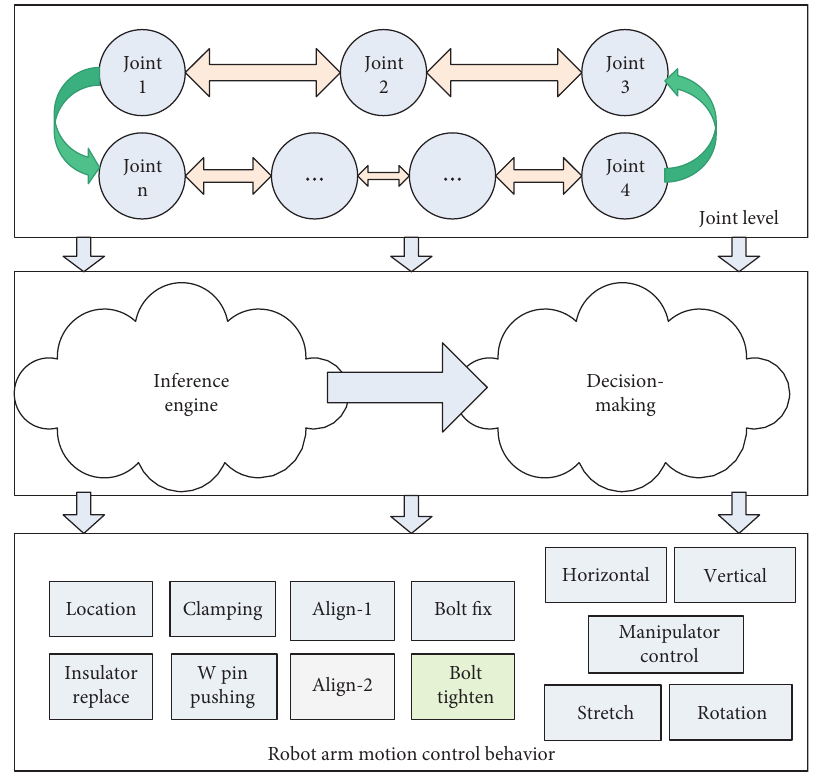
Figure 6: Robot task decomposition and behavior